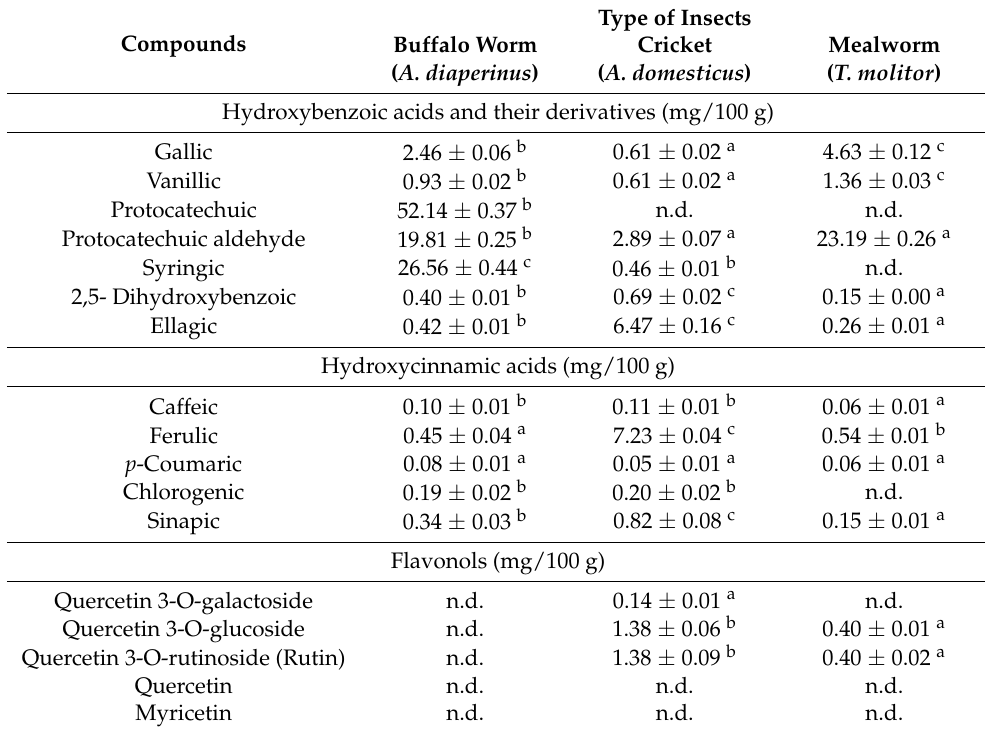
Table 1. Profile of phenolic compounds of edible insect flours. Compounds